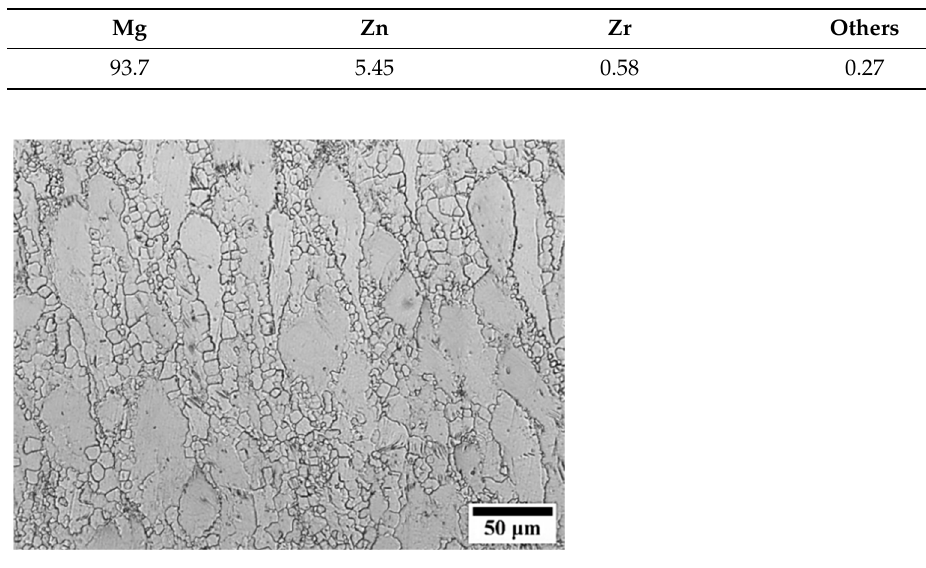
Figure 1. Microstructure of ZK60-T5.